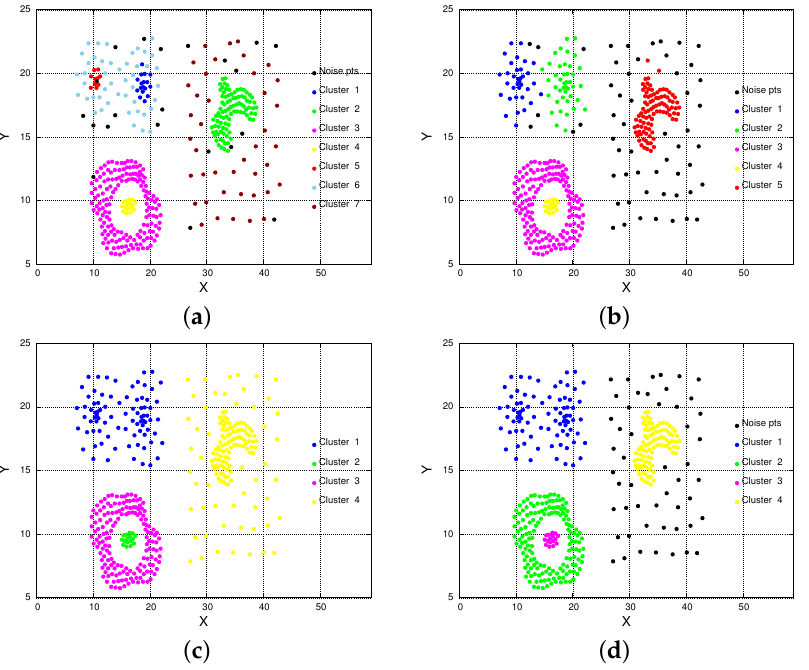
Figure 9. The Compound dataset: detected clusters. ( a ) CHD. ( b ) DBSCAN. ( c ) HDBSCAN. ( d )